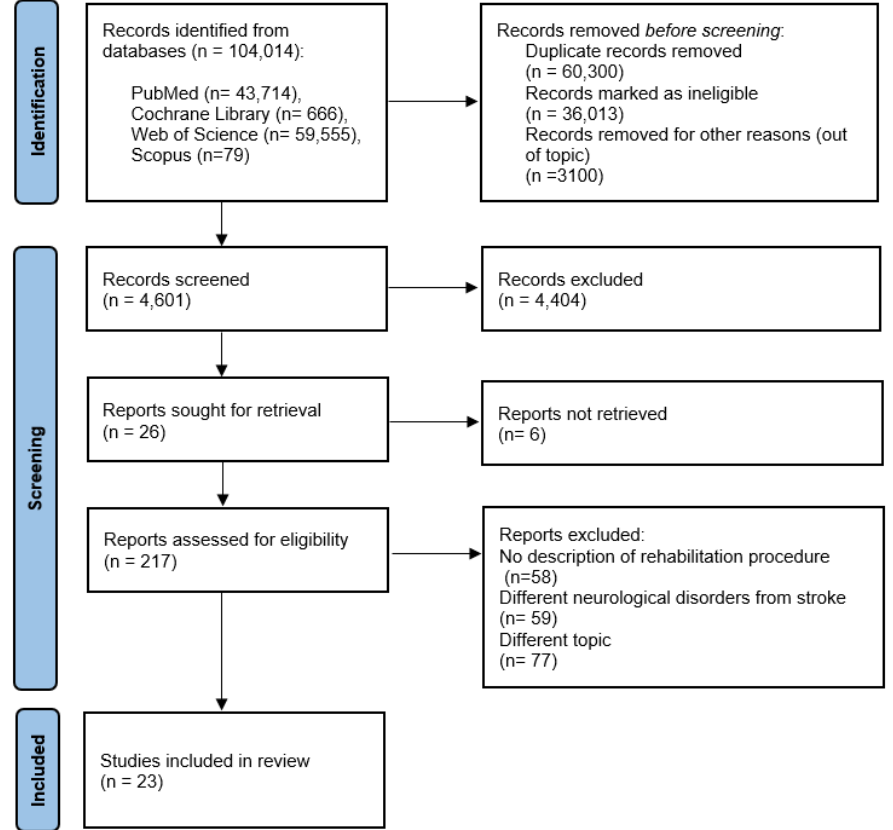
Figure 1. Flowchart of the process of literature search and extraction of studies.